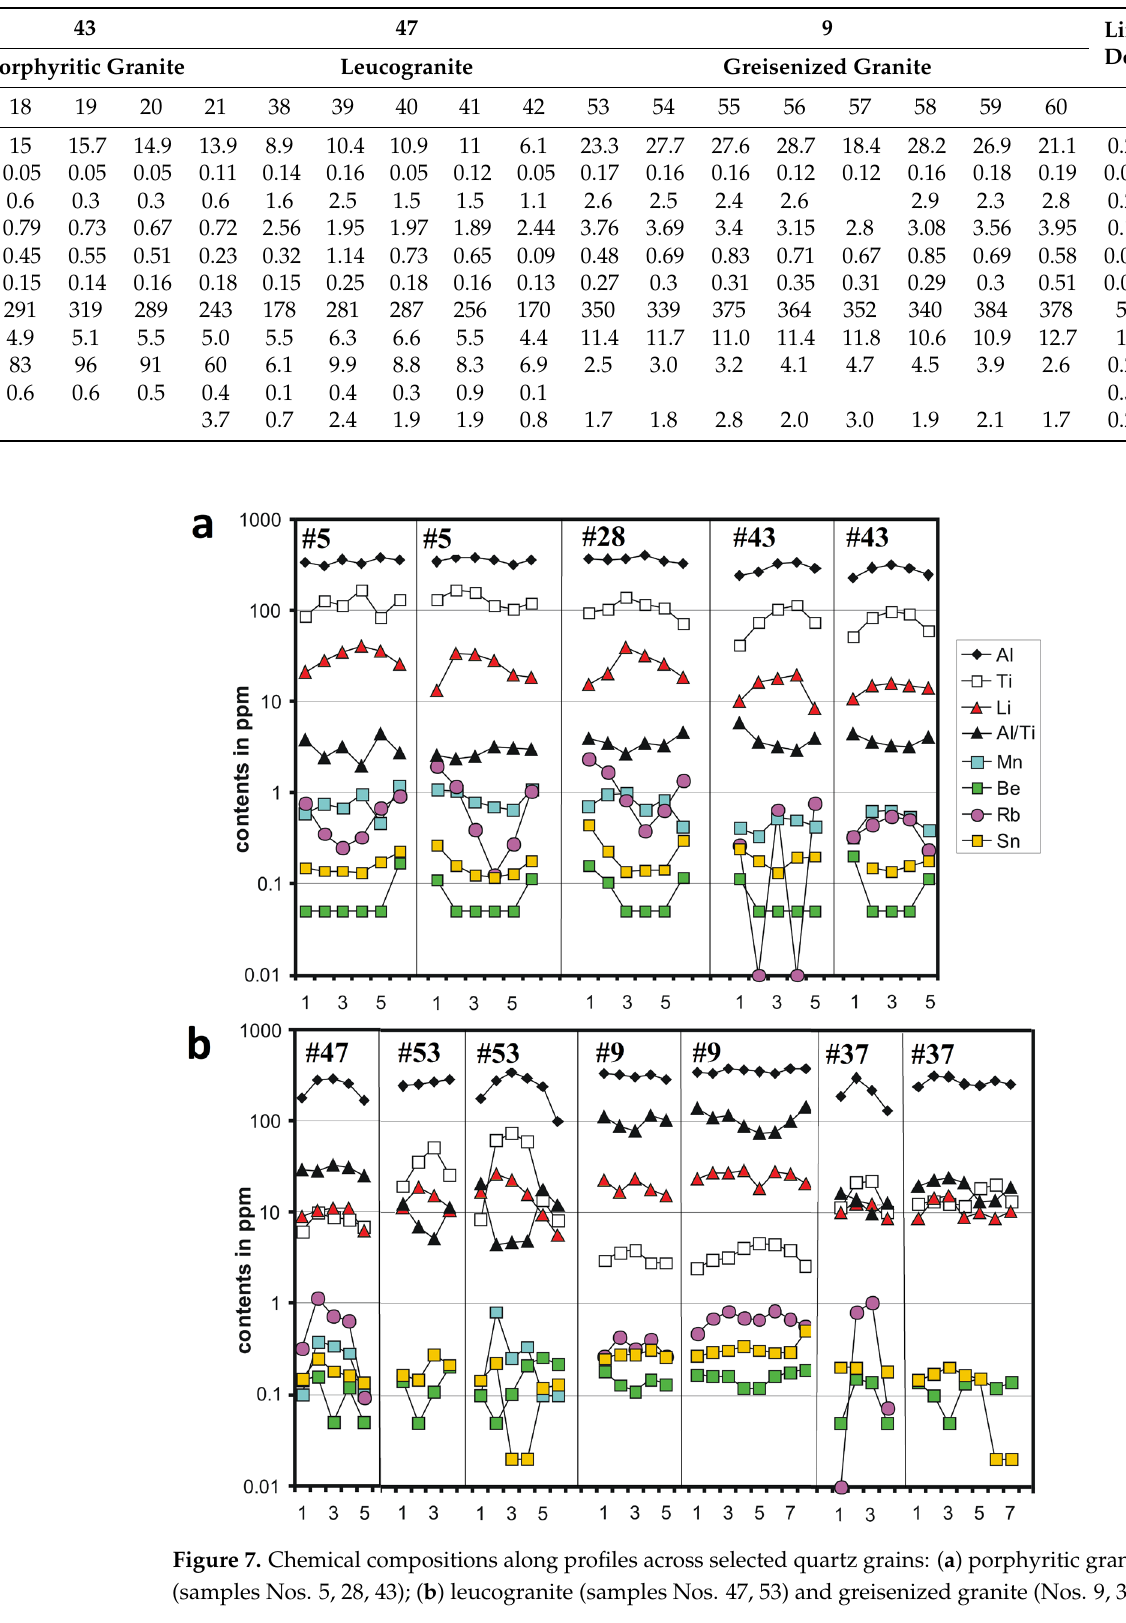
Table 3. Contents of trace elements in typical quartz crystals in ppm (LA-ICP-MS data). Empty cell—below detection limit.